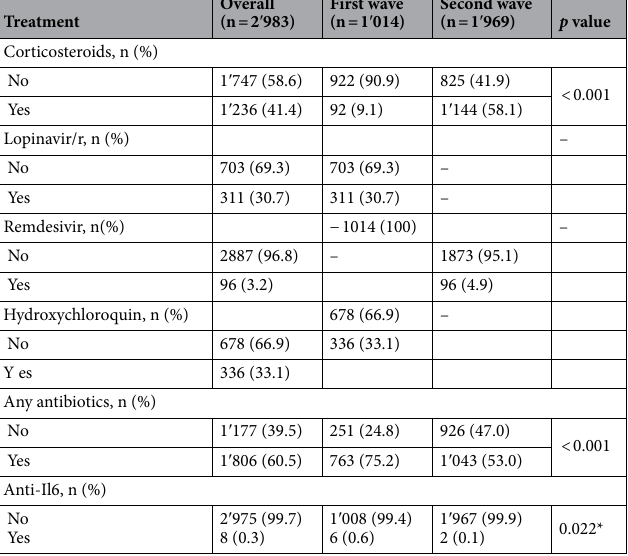
Table 2. Treatment administered during the two successive